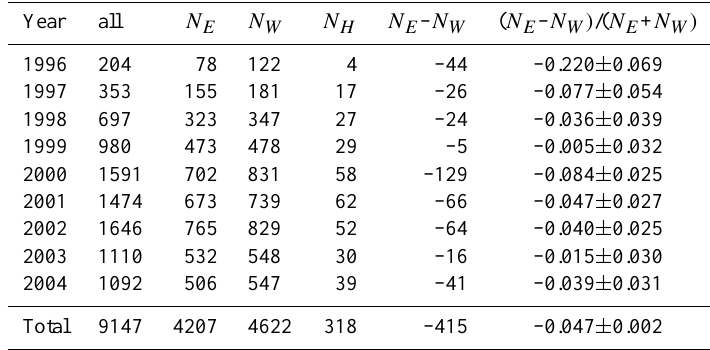
Table 1. Statistics of east-west asymmetry in SOHO LASCO